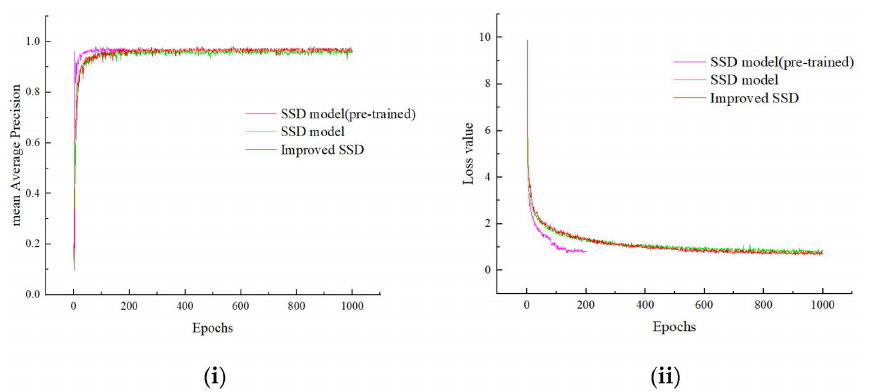
Figure 9. The change curve in the comparison test whether to load the pre-trained model. ( i ) Mean average precision. ( ii ) Loss value.